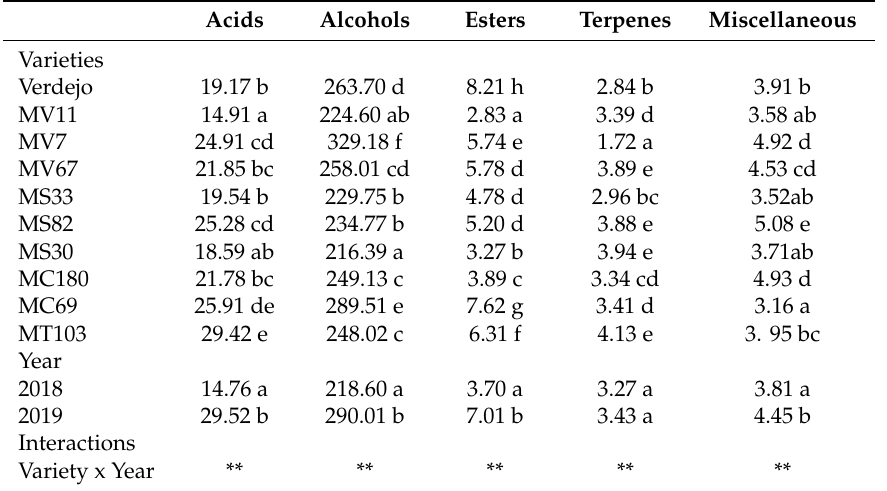
Table 5. Analysis of variance of Verdejo and di ff erent white crosses during 2018 and 2019 season. Acids Alcohols Esters Terpenes Miscellaneous Varieties Verdejo